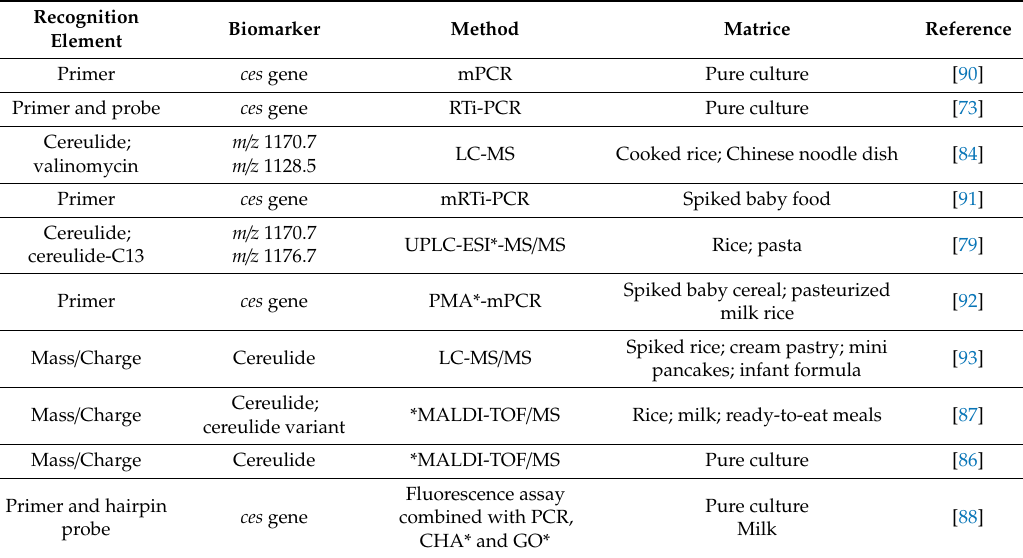
Table 2. Detection methods for cereulide and emetic B. cereus vegetative